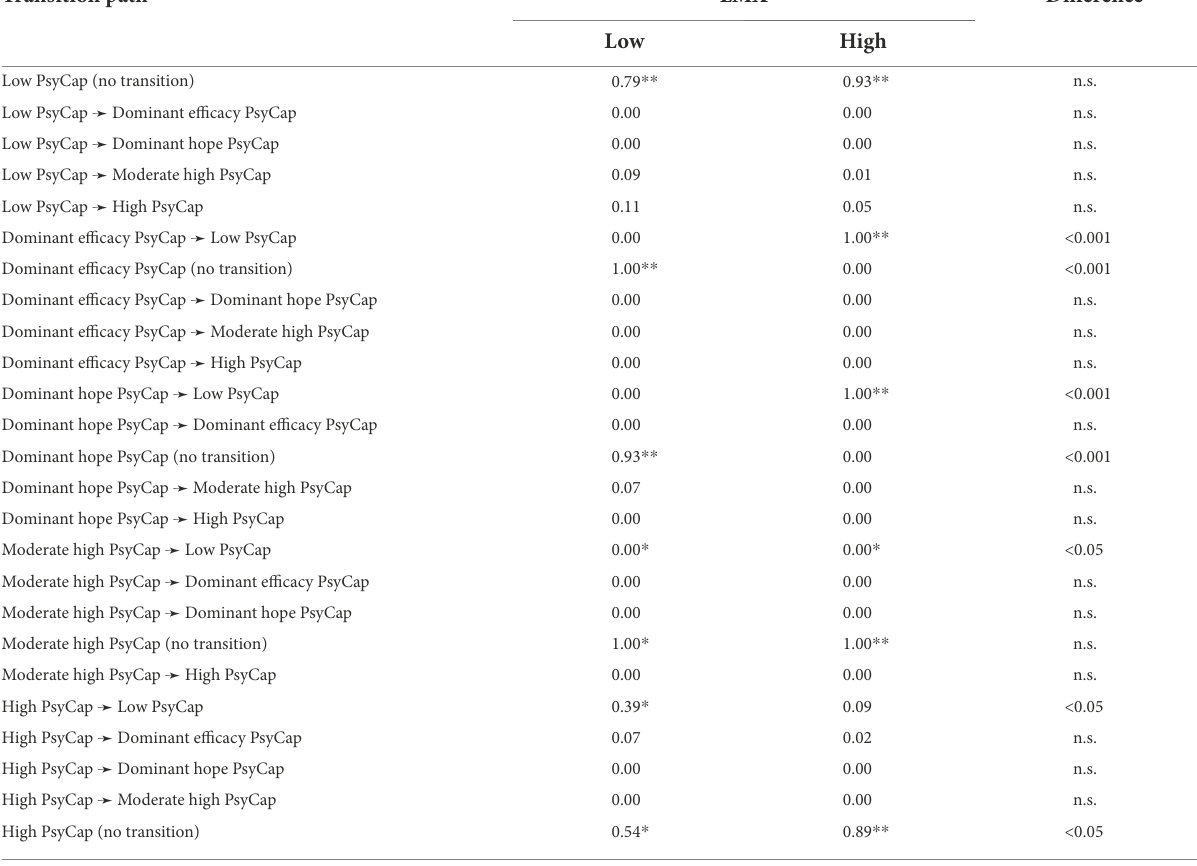
TABLE 5 Conditional transition probabilities across lower and higher levels of